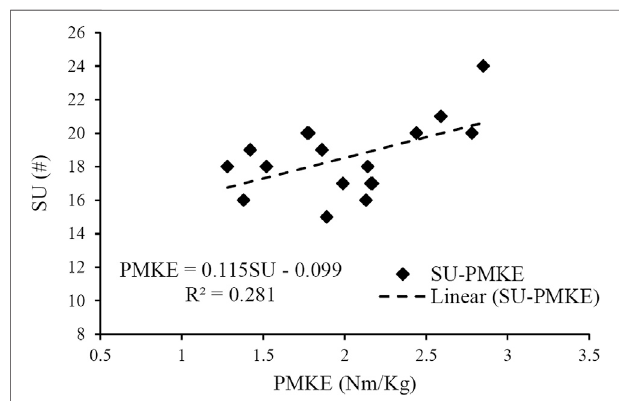
FIGURE 3 | Results of linear regression analyses of the peak moment of knee extension (PMKE) with the fi ve core-related measurements, which included dominant extremity single-leg hop distance normalized by body height (DLH/H), sit-ups in 20 s (SU), dominant extremity single-leg stance time (DLS), trunk fl exion and extension range of motion (TFE), trunk extensor endurance (EE).